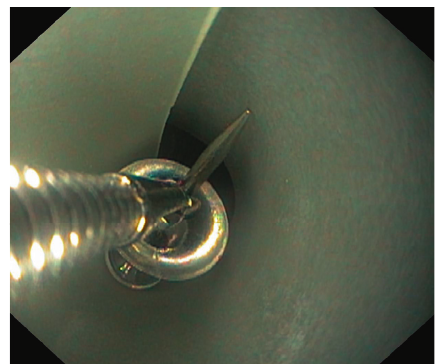
Figure 4: Testing if the foreign body fits in the hood before inserting the